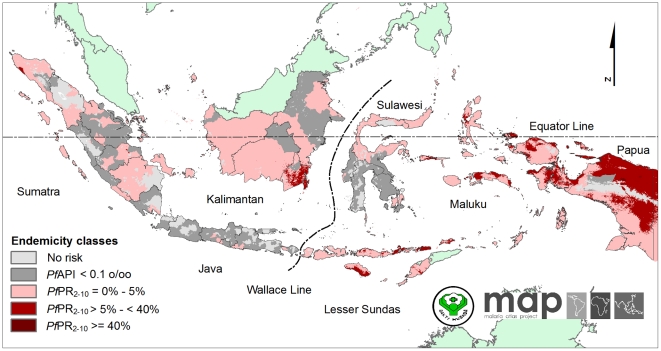
The Plasmodium falciparum malaria PfPR2–10 predictions stratified by endemicity class.They are categorized as low risk (PfPR2–10≤5%), intermediate risk (5%<PfPR2–10<40%) and high risk (PfPR2–10≥40%). The rest of the land area was defined as unstable risk (medium grey areas, where PfAPI<0.1 per 1,000 pa) or no risk (light grey).